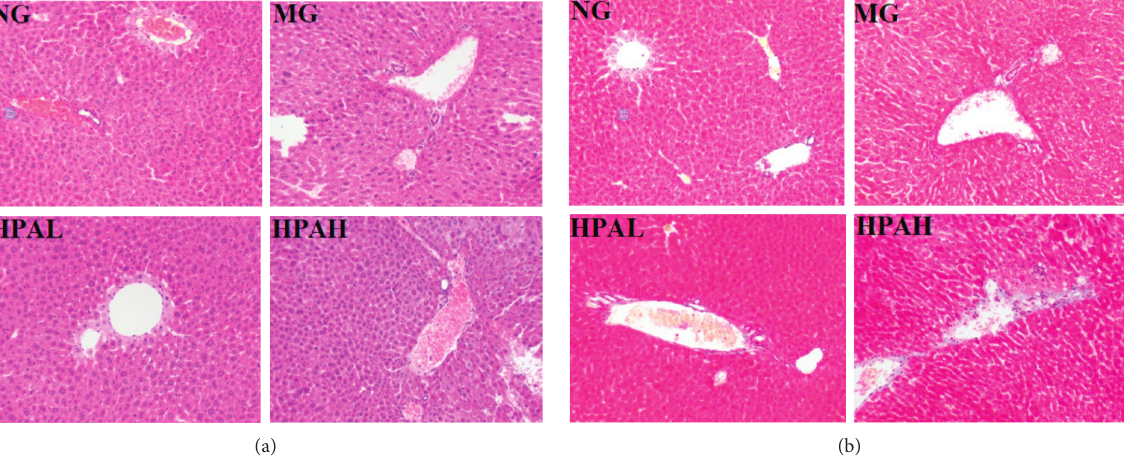
Figure 6: Histopathological detection of livers in ALD mice. (a) H&E staining in liver ( × 200 magnification); (b) Masson staining in liver ( × 200